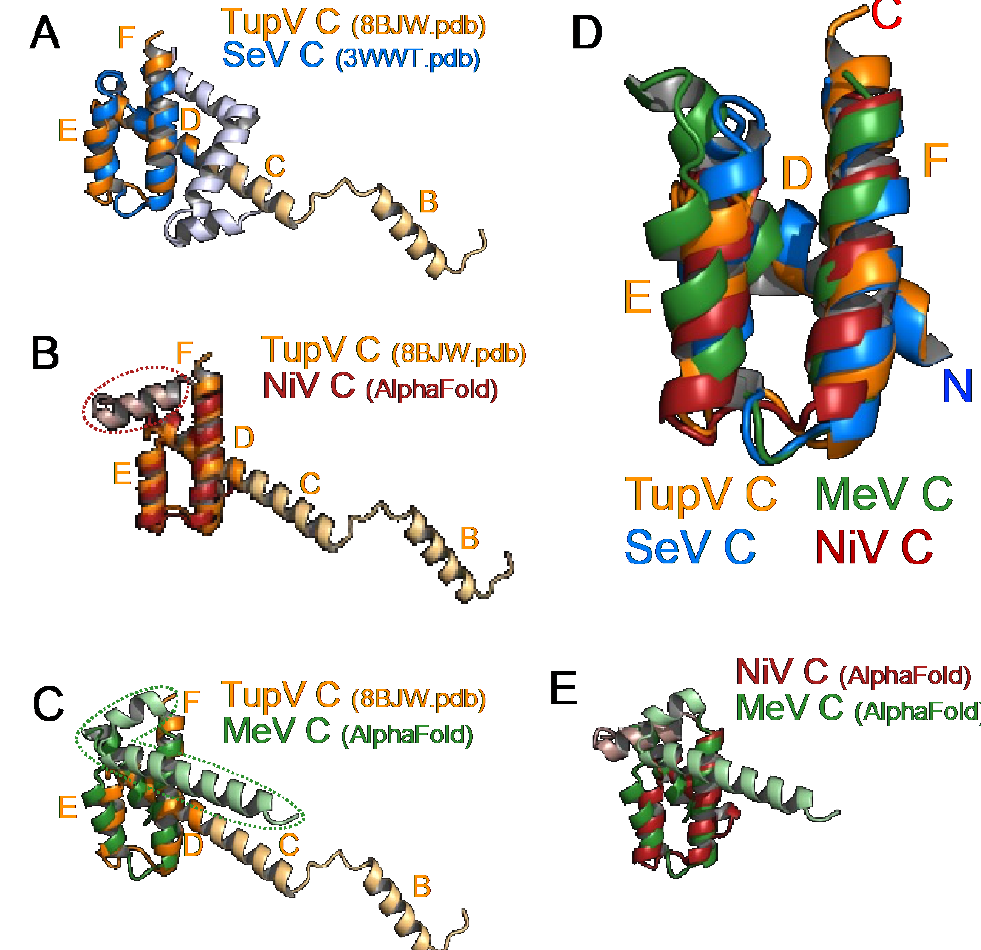
Figure 5. Structural alignments. ( A ) Superposition of TupV C (8BJW.pdb) and SeV C (taken from 3WWT.pdb) crystal structures. The non-superposable parts of TupV and SeV C are, respectively in light blue and light orange. ( B ) Superposition of the crystal structure of TupV C with an AlphaFold model of NiV C (aa 100–166). The averaged DDT score for this model of NiV C is 92.6, which indicates a highly reliable prediction. The additional C-terminal helix of NiV C is circled with a dotted line. ( C ) Superposition of the crystal structure of TupV C with an AlphaFold model of MeV C (aa 101–186). The averaged pLDDT score for this model is 86.0, also indicating a reliable prediction. The additional C-terminal helices of MeV C are shown and circled with a dotted line. ( D ) Superposition of (i) the helical domain of TupV C taken from the crystal structure (8BJW.pdb), (ii) the corresponding regions of SeV C taken from the crystal structure (3WWT.pdb), (iii) an AlphaFold model of MeV C and (iv) an AlphaFold model of NiV C. The N and C-termini and the name of the helices in TupV C (D–F) are labeled. ( E ) Superposition of the Alphafold models of the NiV and MeV C protein